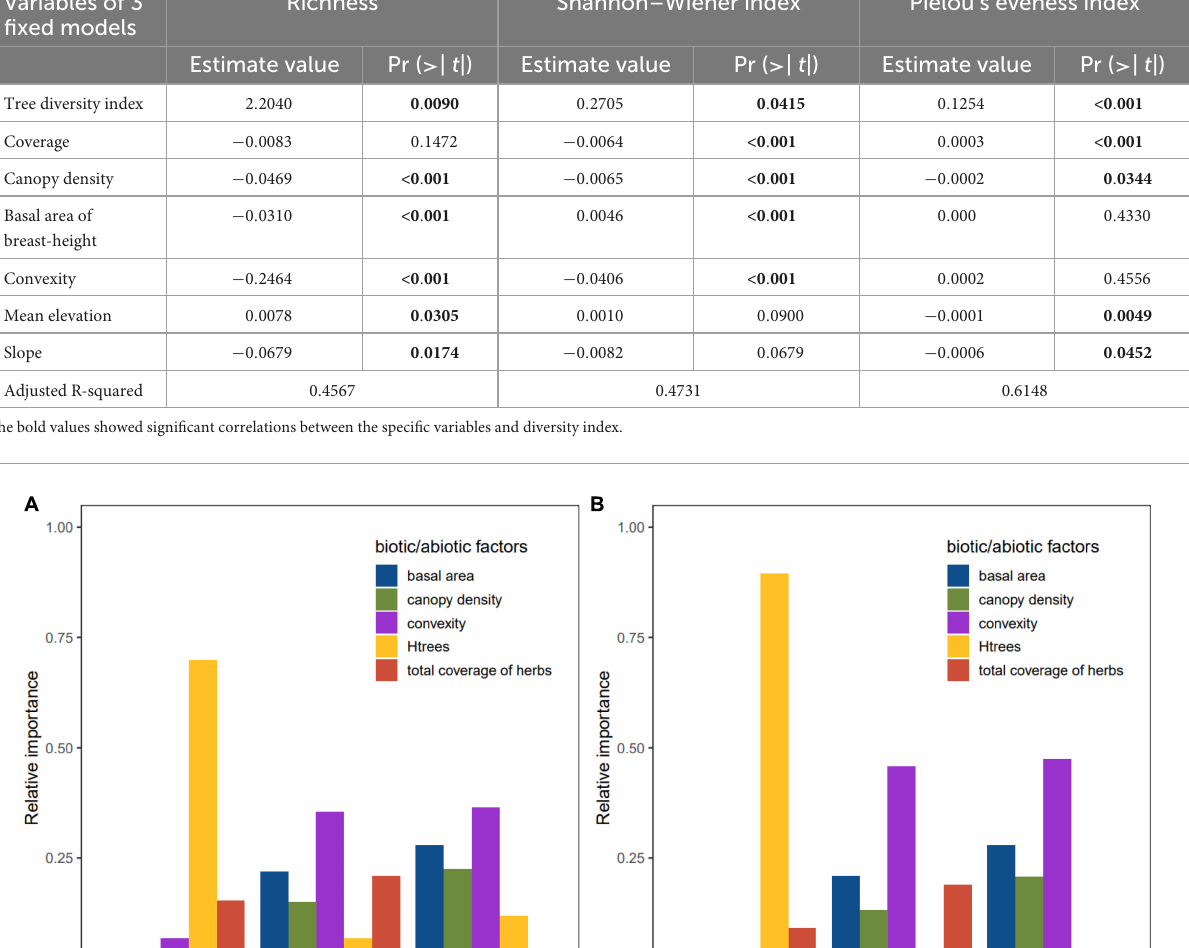
TABLE 3 Multivariable linear regression models of three diversity indices of herbaceous plant community to seven environment factors in Gutianshan subtropical understory. Variables of 3 fixed models